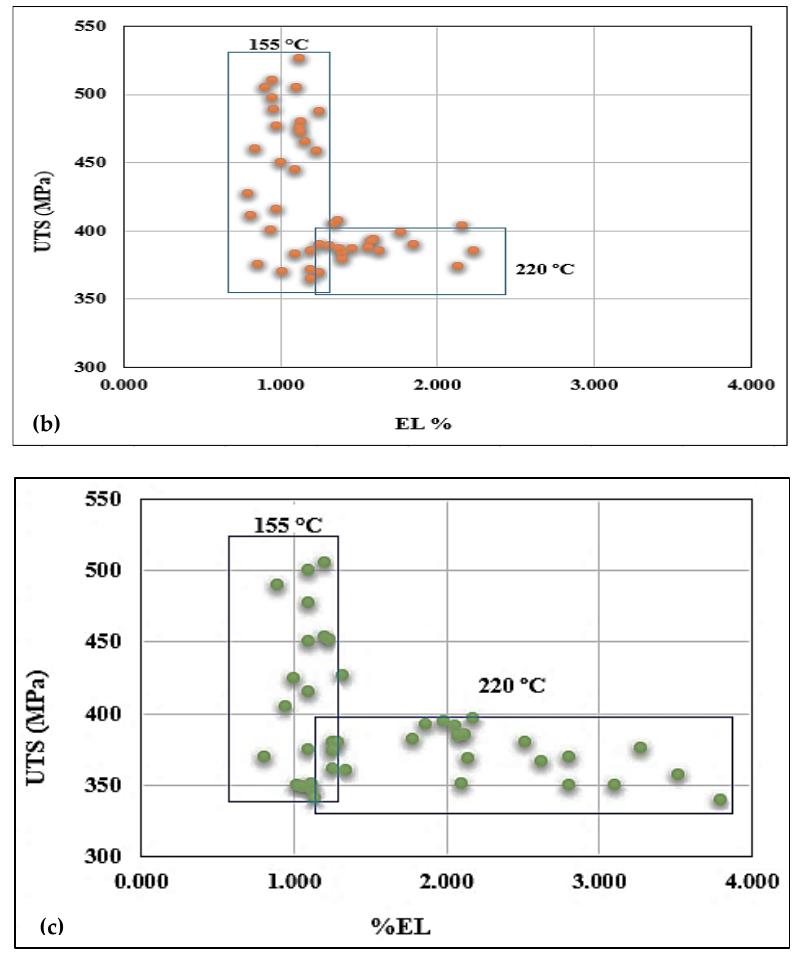
Figure 14. Plots of UTS vs. % Elongation for ( a ) alloy A, ( b ) alloy B, and ( c ) alloy C.